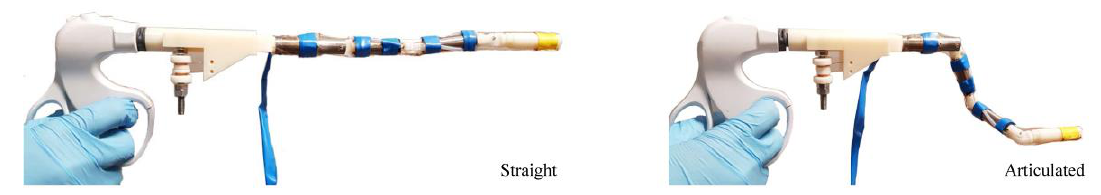
Figure 8. Prototype with three flexible joints in straight ( left ) and articulated ( right ) positions.